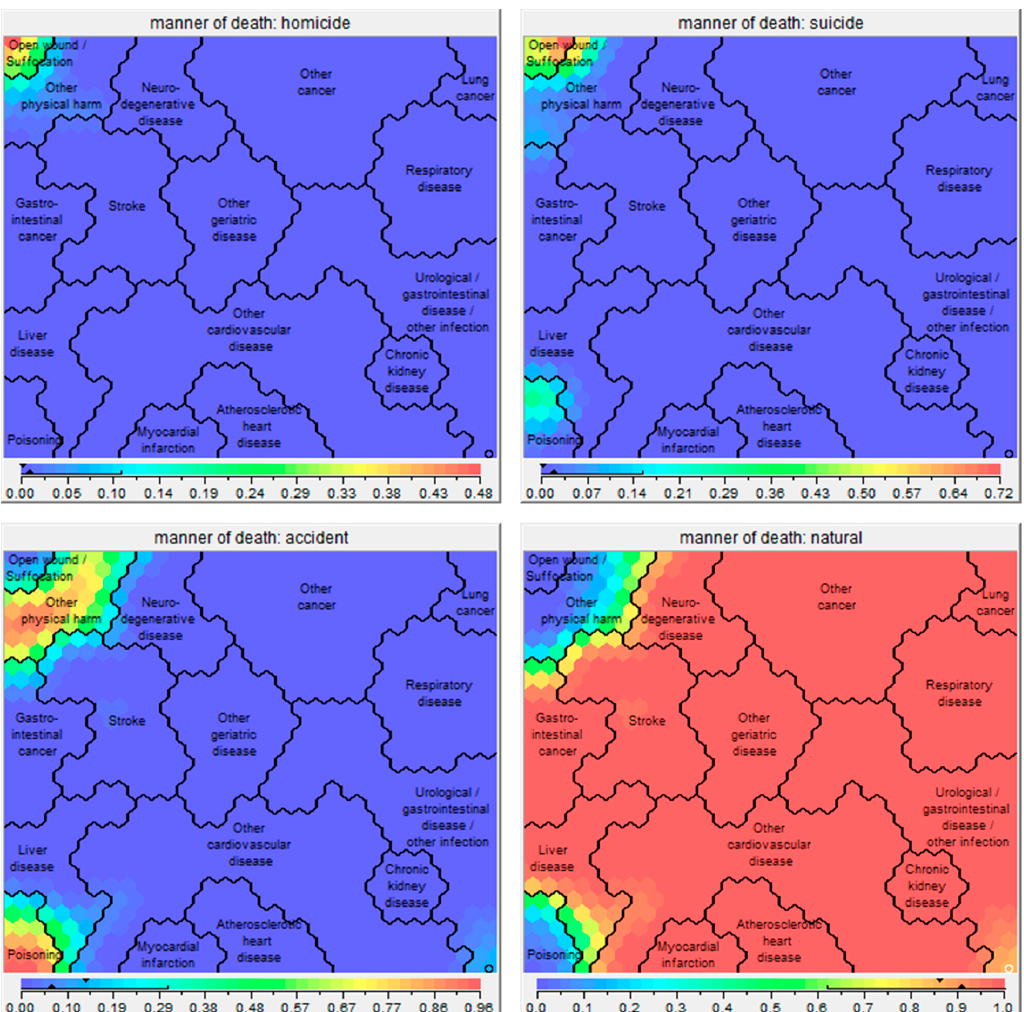
Figure 4. Self-organizing maps showing the manner of death (homicide, suicide, accident, natural death) of the 16 clusters. Red parts of the map consist of high percentages of persons dying in the indicated manner, whereas blue parts consist of low percentages of persons dying in the indicated manner. The exact percentages are given in the bar under the respective map picture.